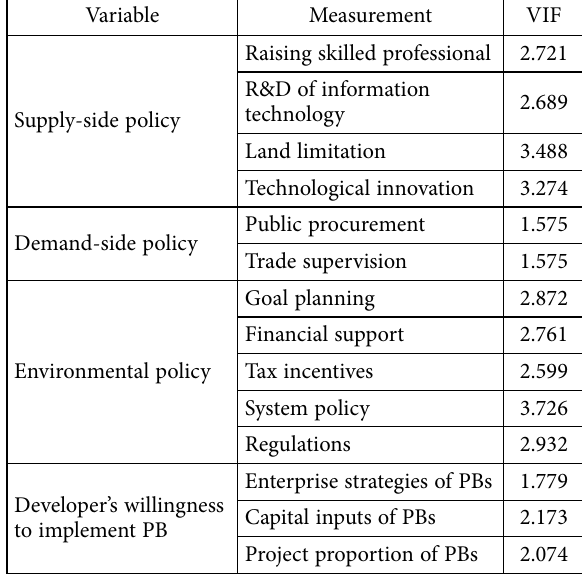
Table 10. The results of multi-collinearity analysis